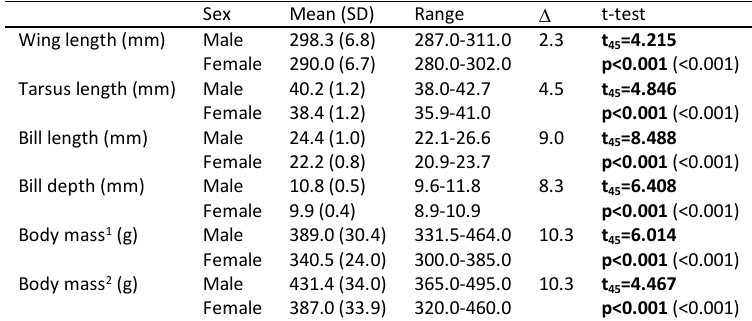
1 before a foraging trip; 2 on return from a foraging trip.